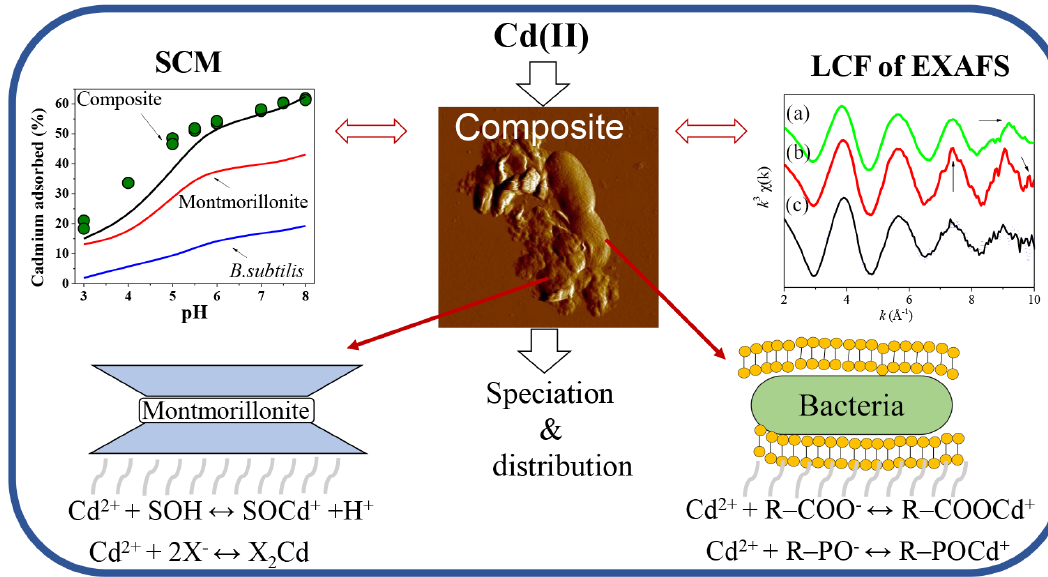
Figure 6. Schematic cartoon illustrating Cd binding on clay–bacteria